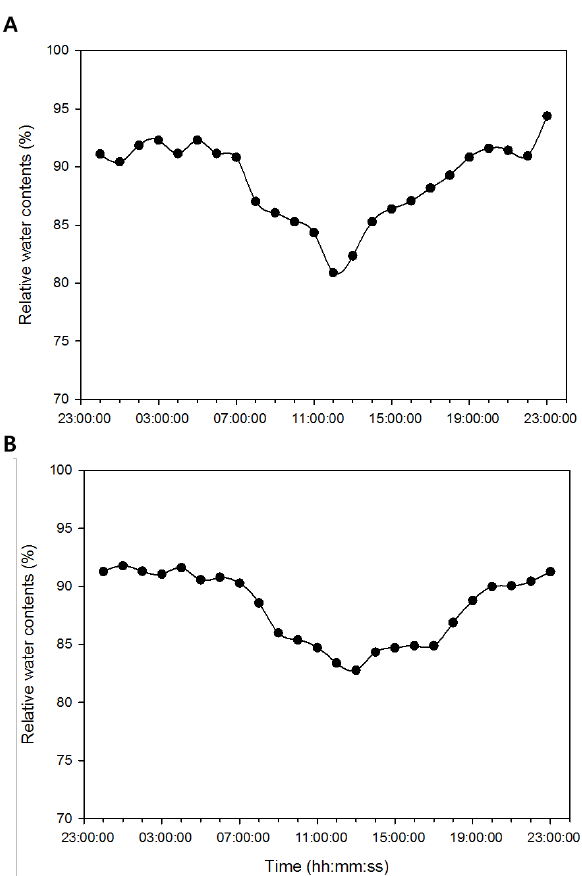
Figure 3. Diurnal changes in relative water content in heated conditions at night (( A ), 27 February 2018) and in unheated conditions at night (( B ), 28 April 2018).